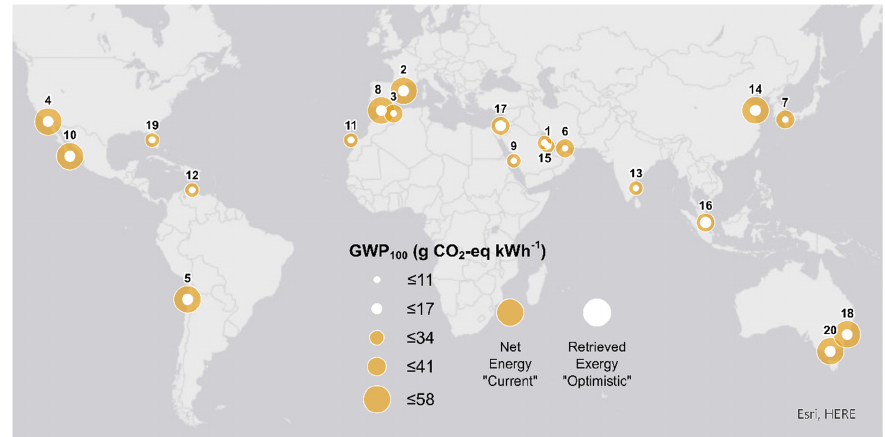
Figure A2. The 100-year Global Warming Potential of the RED plant derived from Equation (B3) in the “current” (Net Energy) and “optimistic” (Retrieved Exergy) energy supply scenarios. RED stack: 1000 cell pairs, 0.175 m 2 effective membrane area per cell pair (Table 2). RED stack’s working